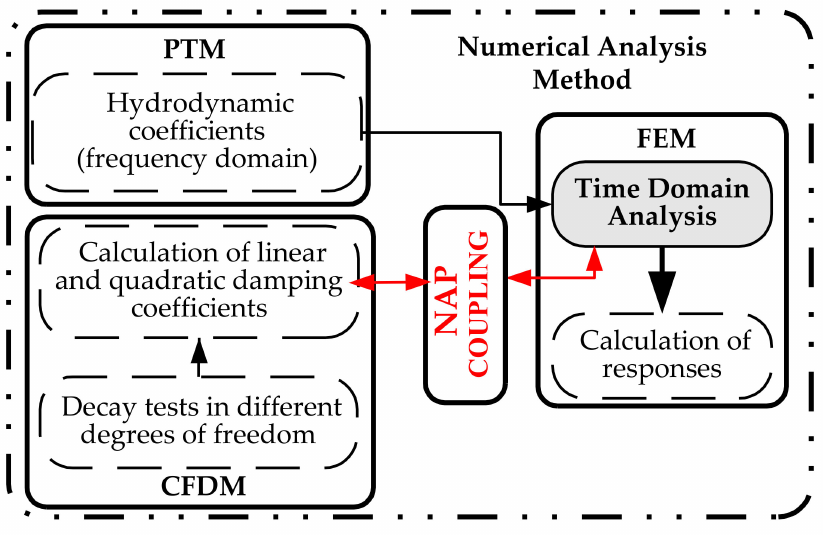
Figure 2. An outline and interconnections of the proposed numerical analysis method. A description of the different models used in the present paper is presented